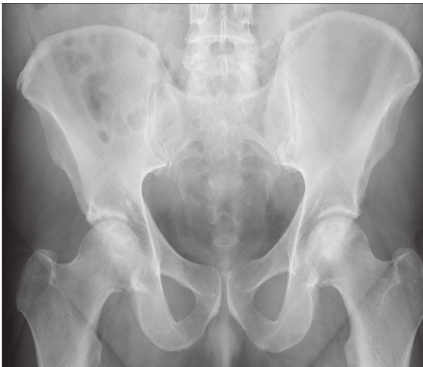
Figure 5: Anterior-posterior hip X-rays in patient number 4 after 13 years on Coumadin. The right hip is unchanged, Ficat stage